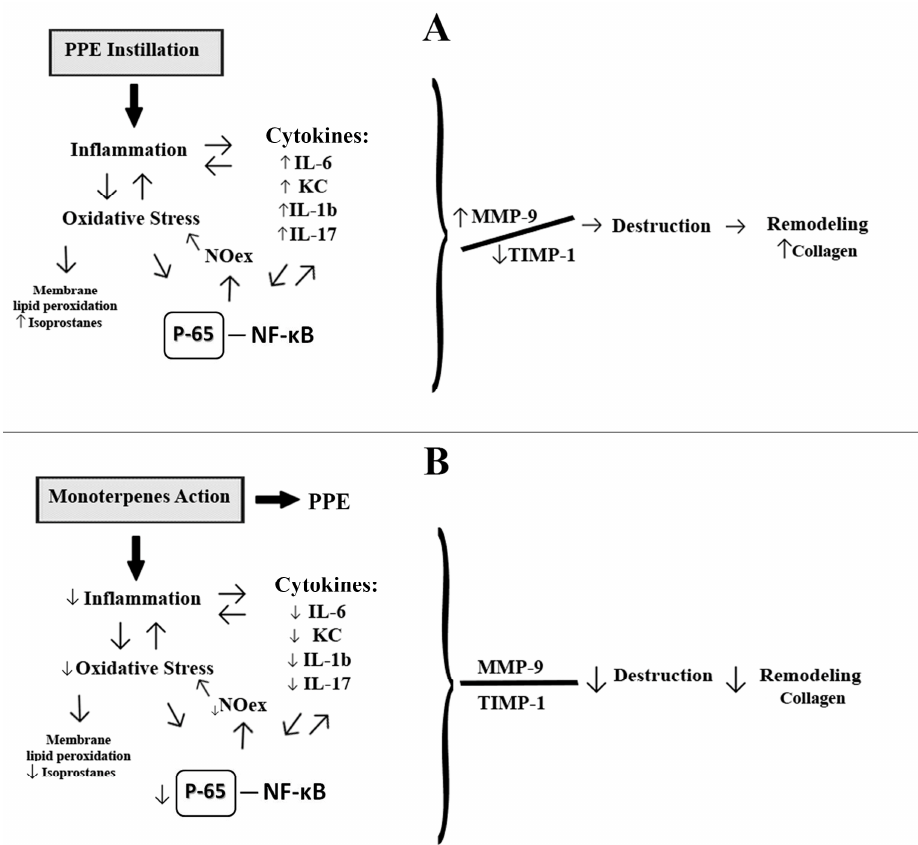
Figure 6. Monoterpenes probably mechanism is related to reduction in inflammation, oxidative stress and in NF- κ B in lung of PPE-instilated animals. ( A ) The PPE instillation induces inflammation and increase marker of oxidative stress. Cytokines such as IL-6, KC, IL-1 β and IL-17 are released and induce the perpetuation of inflammation. Together with oxidative stress, there is activation in NF- κ B pathway, which in turn up-regulated transcription of proinflammatory cytokines and iNOS, that can induce an increase in exhaled nitric oxide. Augment in MMP-9 positive cells can amplify inflammation and contribute to the destruction of lung tissue culminating with collagen fibers deposition; ( B ) The administration of monoterpenes led to a reduction of the inflammatory process and consequent reduction in oxidative stress, which is related to the effects of monoterpenes in cytokines reduction (IL-6, KC, IL-1b and IL-17), NF- κ B and isoprostane. These anti-inflammatory and antioxidant effects contributed to reduction in tissue destruction.